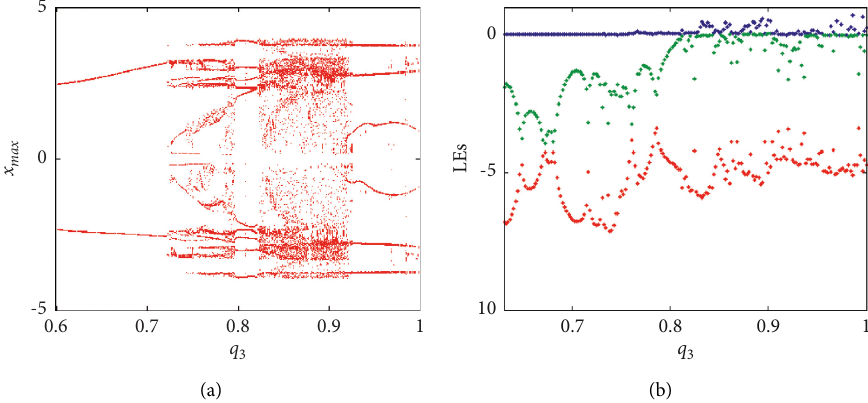
Figure 5: (a) The diagram of bifurcation. (b) Lyapunov exponents of system (4) when q parameters a � 1 and b � − 9 and the IC ( x